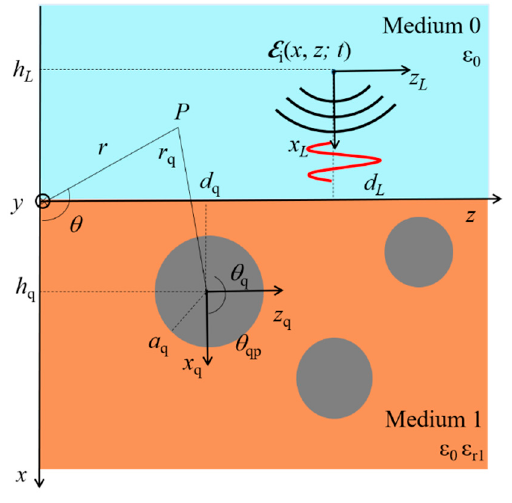
Figure 1. Geometry of the scattering problem.